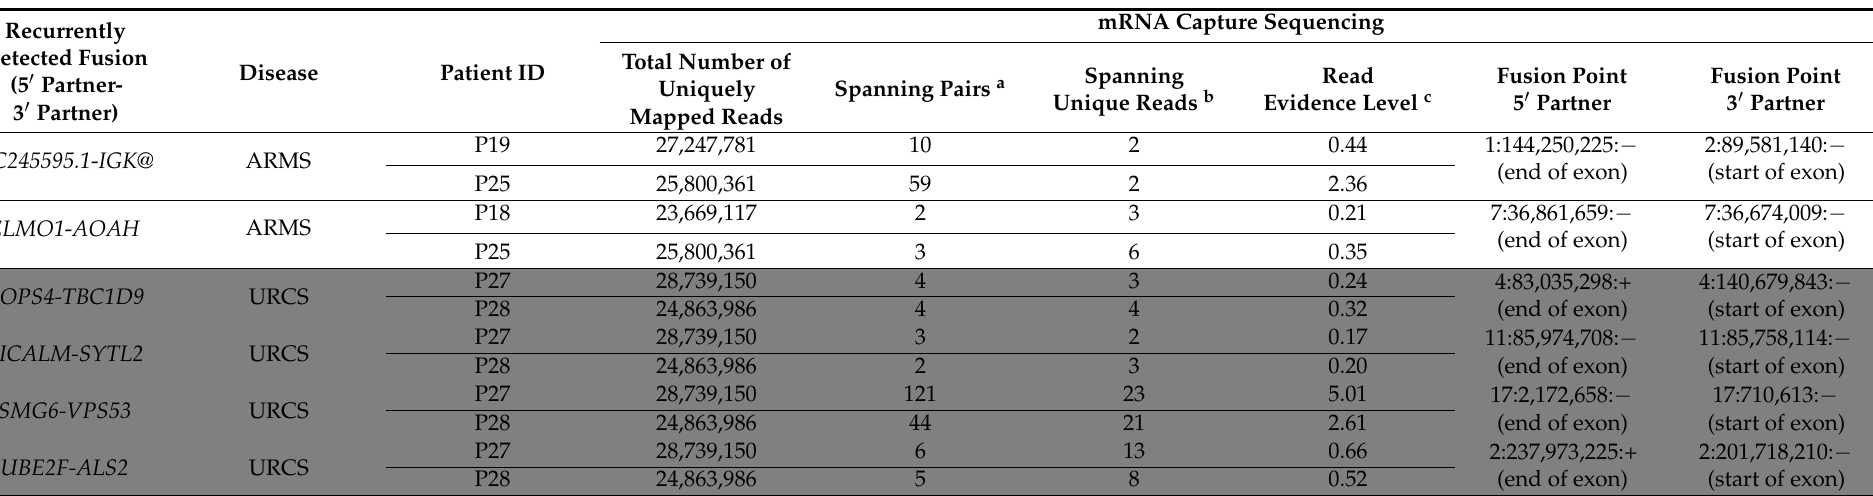
Table 3. mRNA capture sequencing detects recurrent fusion transcripts in sarcoma. For patients in cohort II (unique patient ID), the TruSeq RNA Exome sequencing results of the recurrently detected novel fusion transcripts are listed, excluding falsely identified fusion transcripts and selecting transcripts with fusion events at exon-exon borders (see Section 4). RT-qPCR confirmed transcripts are indicated in gray (assays designed using the Shiny app DNA Melting Thermodynamic